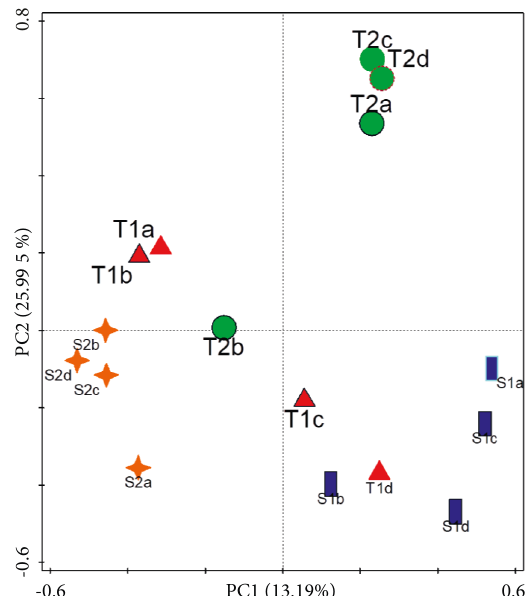
Figure 3: Evaluation of the beta diversity as depicted with principal coordinate analysis. T1a–d and T2a–d mean termite mounds from Braklaagte and Zeerust, respectively, while S1a–d and S2a–d mean adjacent soils from Braklaagte and Zeerust, respectively.